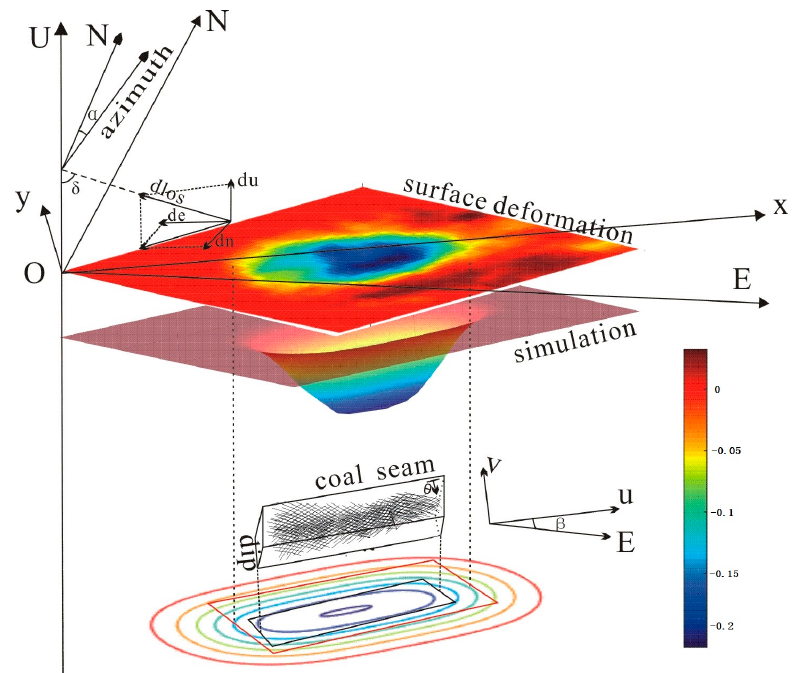
Figure 4. Sketch of the proposed method. The relationship between the surface deformation and the Fig 4 simulation and angles. Coordinates mentioned before are shown in the figure. The black rectangle represents the real position of the goaf and the minimum of the integral region. The red rectangle represents the defined position of the goaf and the maximum of the integral